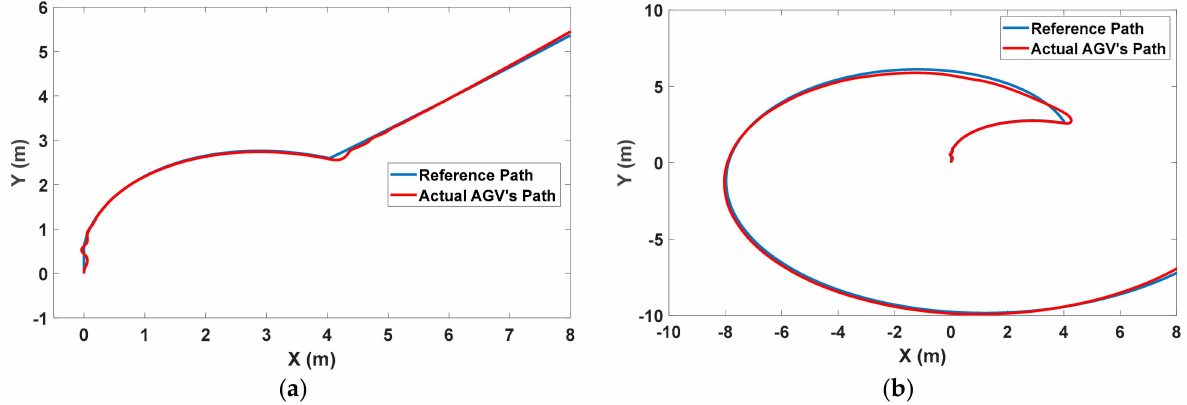
Figure 7. ( a ) The reference path for determining the optimal parameters and tracking perfor- mance with these parameters. ( b ) Testing the tracking performance of the same parameters with another path.